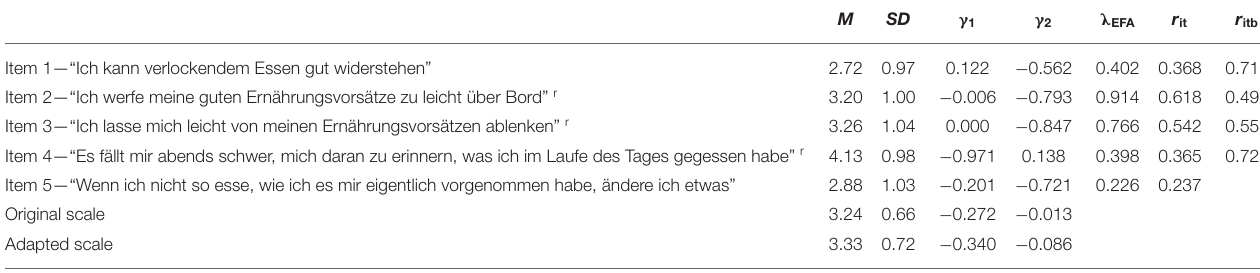
TABLE 2 | SREBQ item and scale characteristics (Sample